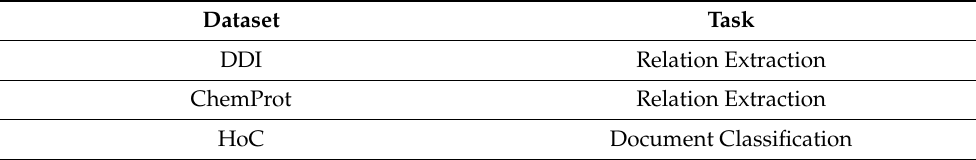
Table 1. Dataset